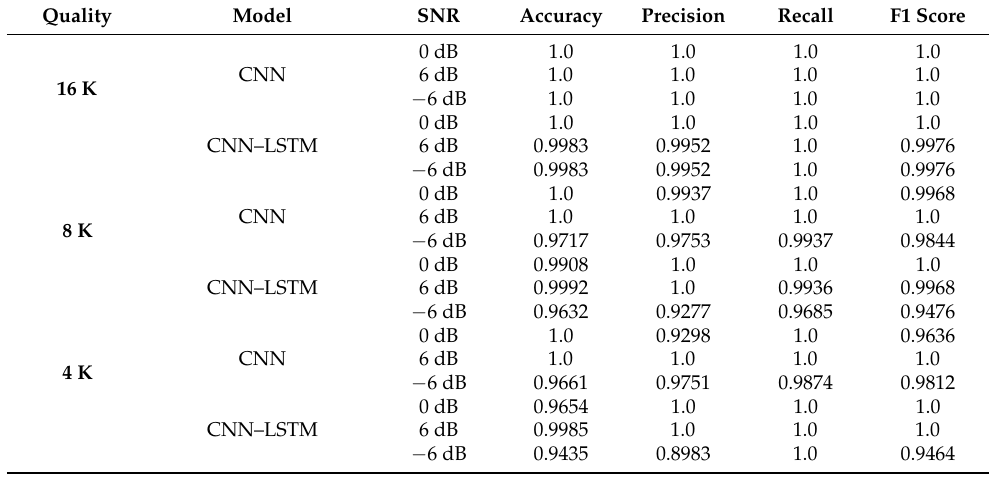
Table 3. Result of training on the CNN and CNN–LSTM models by performing the STFT for valve